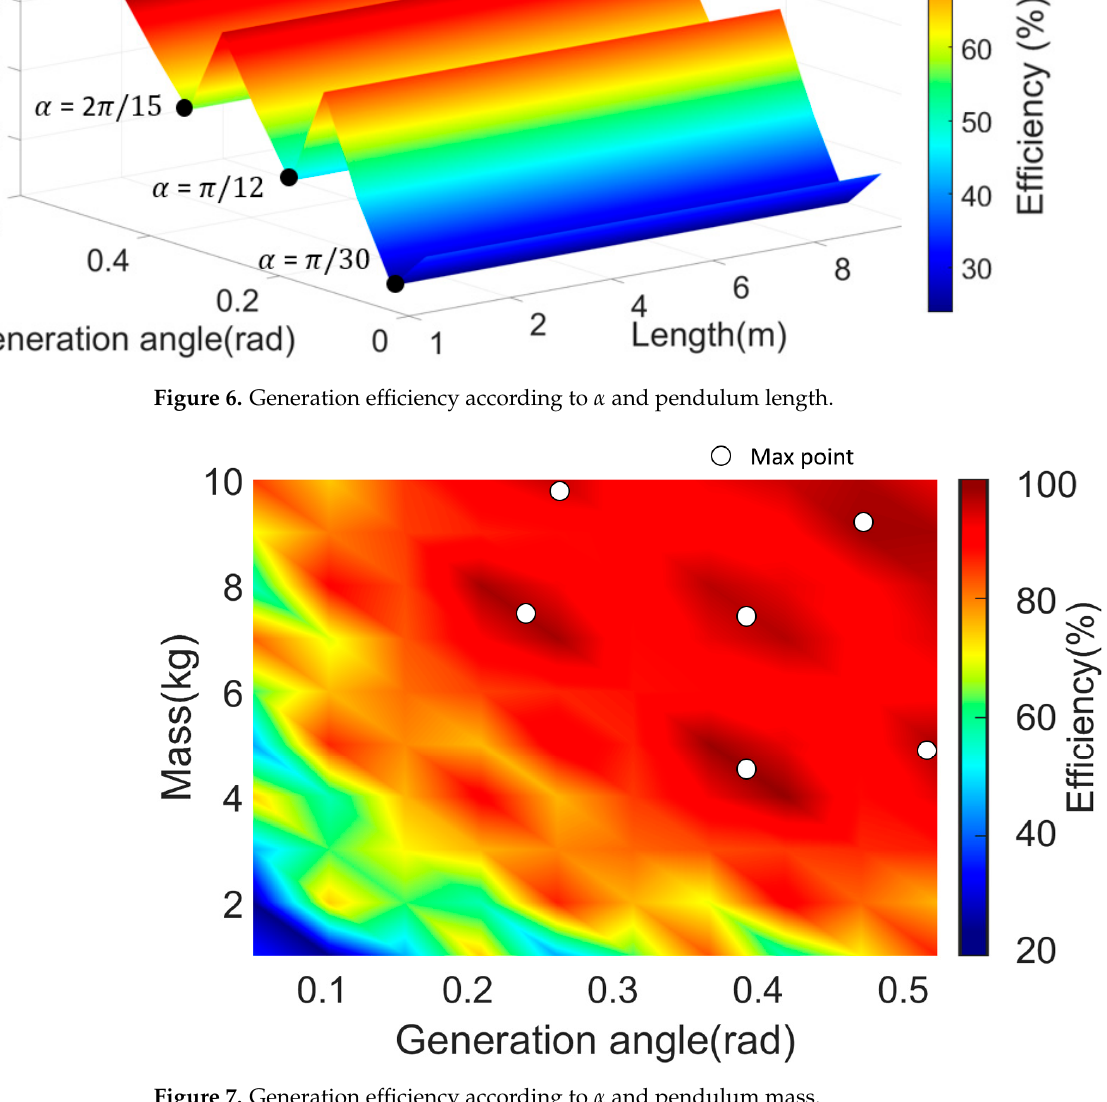
Figure 7. Generation efficiency according to 𝛼 and pendulum mass